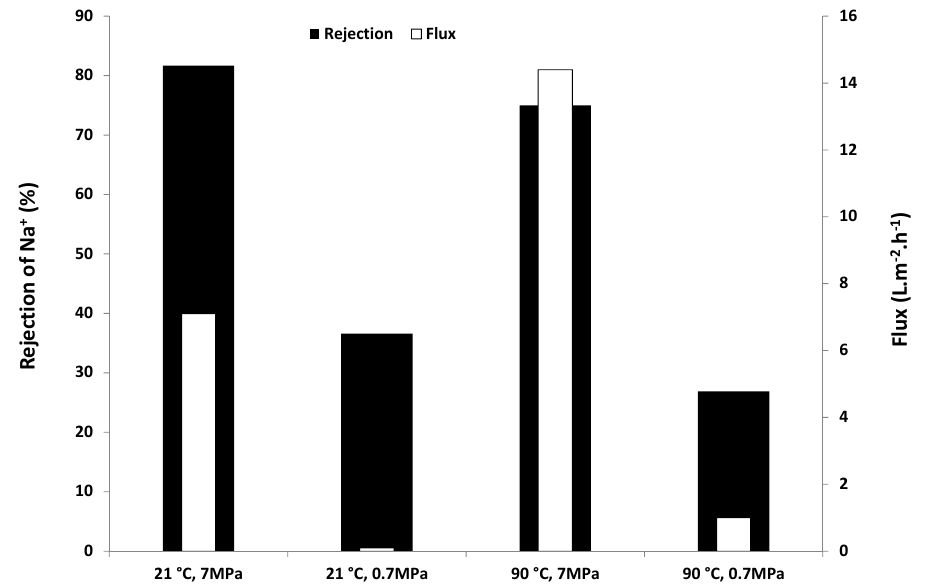
Figure 1. Na + rejection and flux on the zeolite membrane for the NaCl feed solution (total dissolved solids (TDS) of 3000 mg·L − 1 ) under different applied pressures and